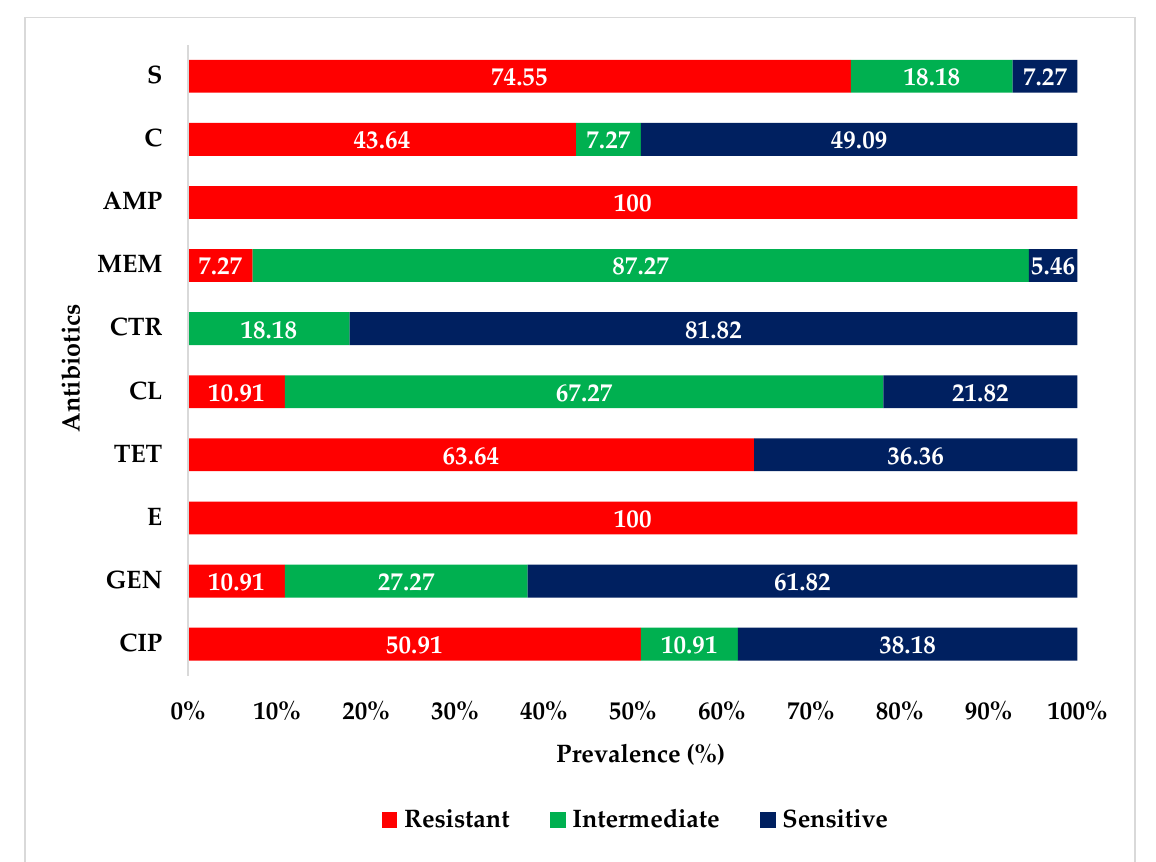
Figure 1. Antibiogram profiles of E. coli isolated from fecal samples of migratory birds. CIP = ciprofloxacin; GEN = gentamicin; E = erythromycin; TE = tetracycline; CL = colistin; CTR = ceftriaxone; MEM = meropenem; AMP = ampicillin; C = chloramphenicol; S = streptomycin.